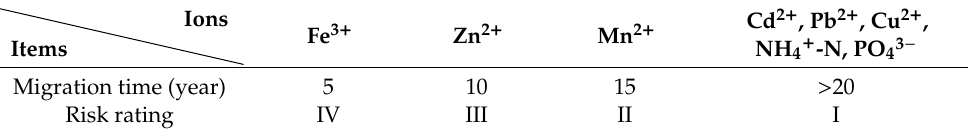
Table 11. Summary of the migration time for each chemical